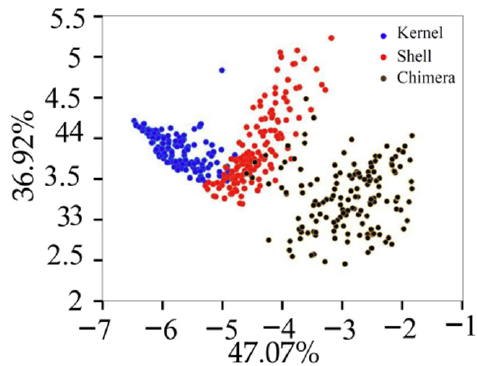
Figure 6. Projection of the validation set in the PCA.